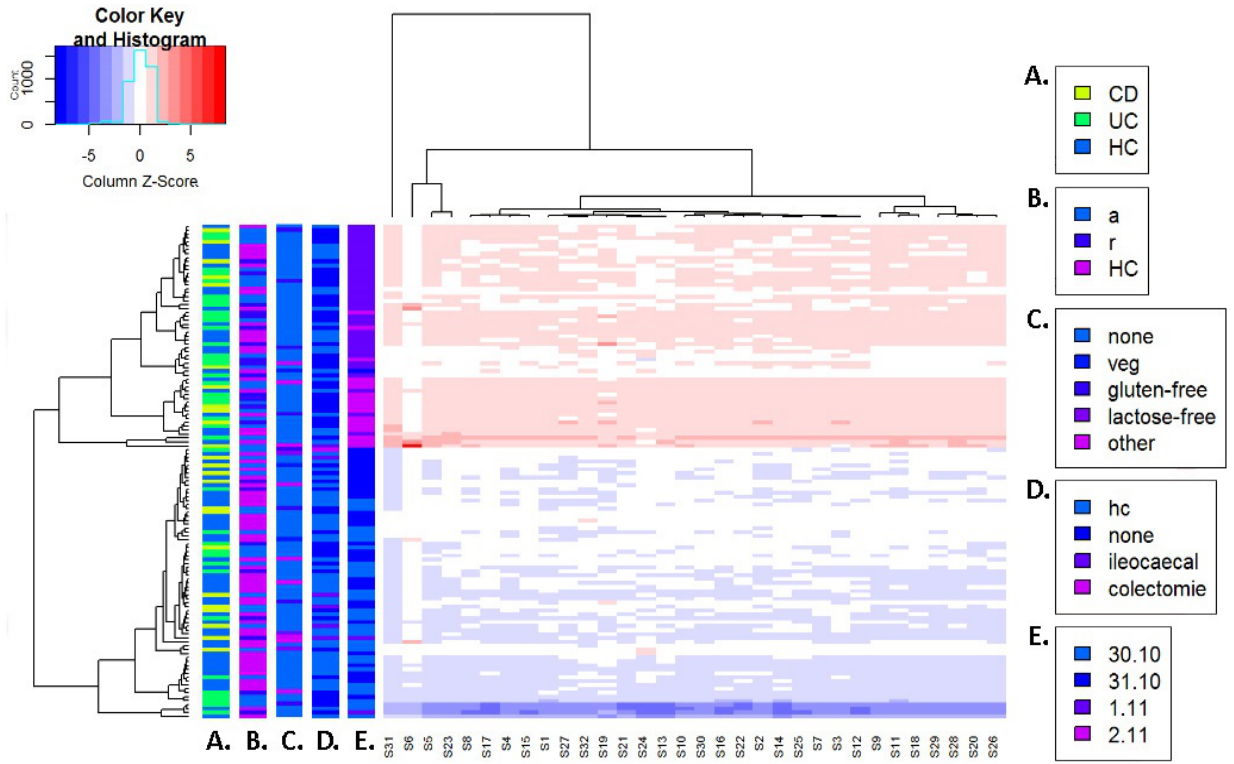
Figure 2. Scaled heatmap of sensor output before correction for date of measurement. The mean and standard deviation per sensor across all samples were calculated. Then, each sample measurement was subtracted from the mean sensor outcome and divided by its standard deviation. This was performed across all sensors and samples so that all sensor measurements were on the same scale. Samples are depicted on the Y-axis, while sensors are depicted on the X-axis. Colored strips on the Y-axis depict the distribution of sample characteristics amongst the samples. ( A ) Distribution of CD, UC and controls. ( B ) Distribution of active disease or remission; control samples are depicted as separate group. ( C ) Distribution of diet including no diet, vegetarian diet, gluten-free diet, lactose-free diet and non-specified diets. ( D ) Distribution of abdominal surgical history except appendectomy, including no abdominal surgery, ileocecal surgery and colectomy; control samples are depicted as separate group. ( E ) Distribution of measurement date.